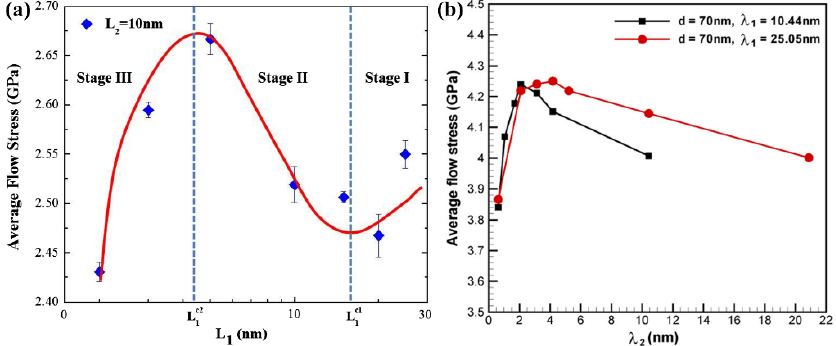
Figure 7. ( a ) The relationship between average flow stress and primary twin spacing λ 1 in the HNT Cu [132], and ( b ) the relationship between average flow stress and secondary twin spacing λ 2 in two ‐ order HNT Cu using MD simulation [133].